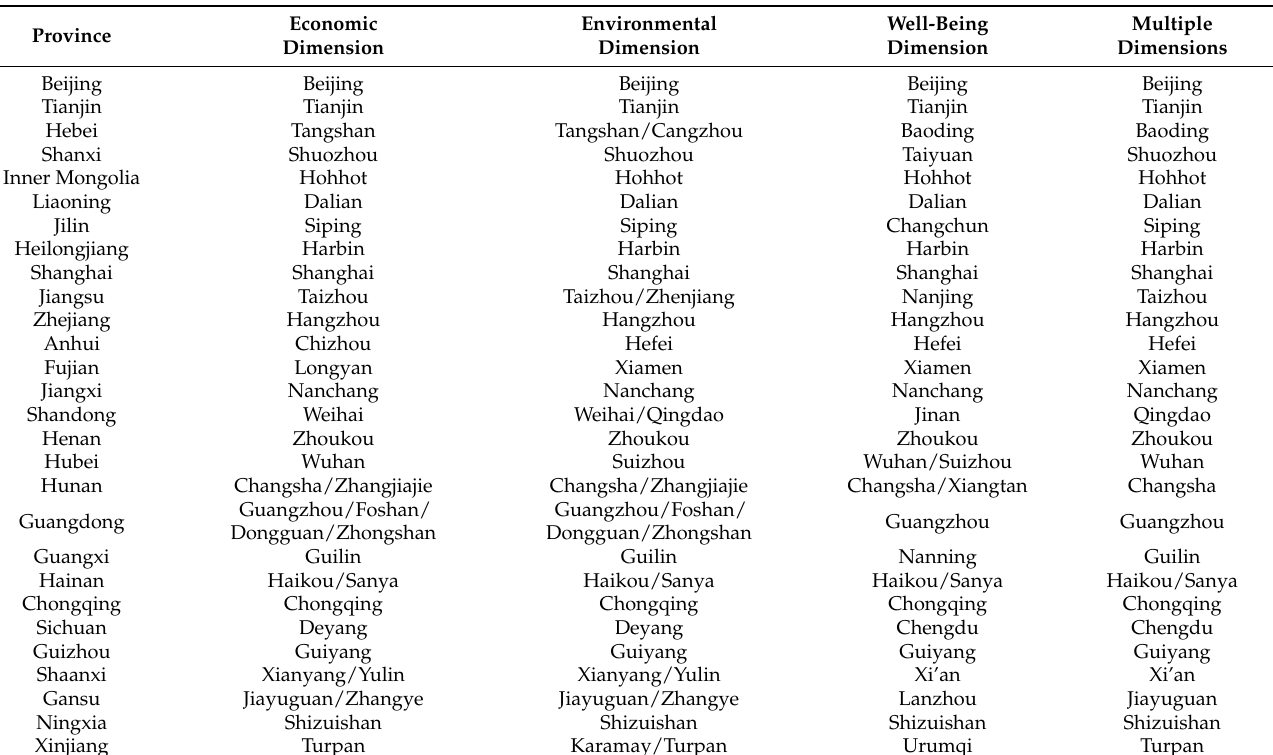
Table 5. The energy performance benchmark city of each province in each dimension and multiple dimensions.